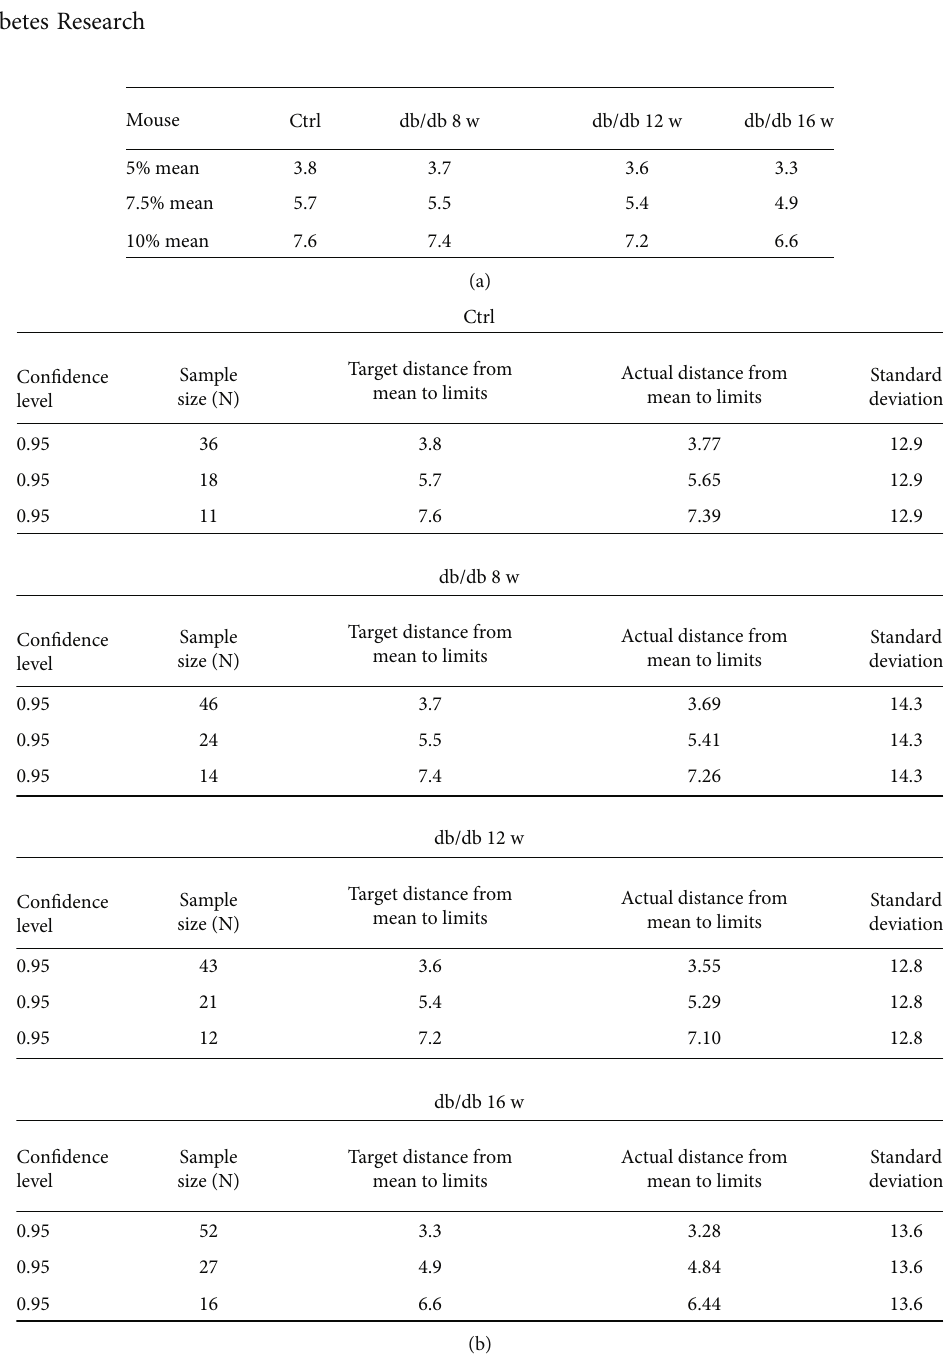
Figure 7: On behalf of the entire podocyte number, a slight number of glomeruli were required in db/db mice. Taking (a) 5%, 7.5%, and 10% of the mean number of podocytes per glomerular as the statistical allowable error with total con fi dence level as 95%, (b) the corresponding sample size of the control group and db/db mice by the age of 8 w, 12 w, and 16 w was separately presented in the table by using the PASS